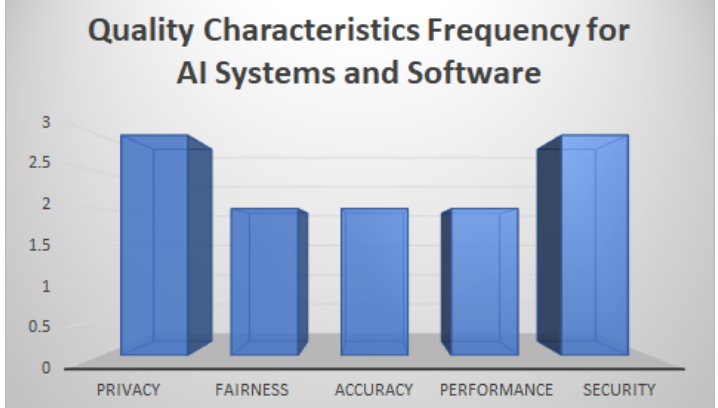
Figure 4. Quality Characteristics Frequency for AI Systems and Software.